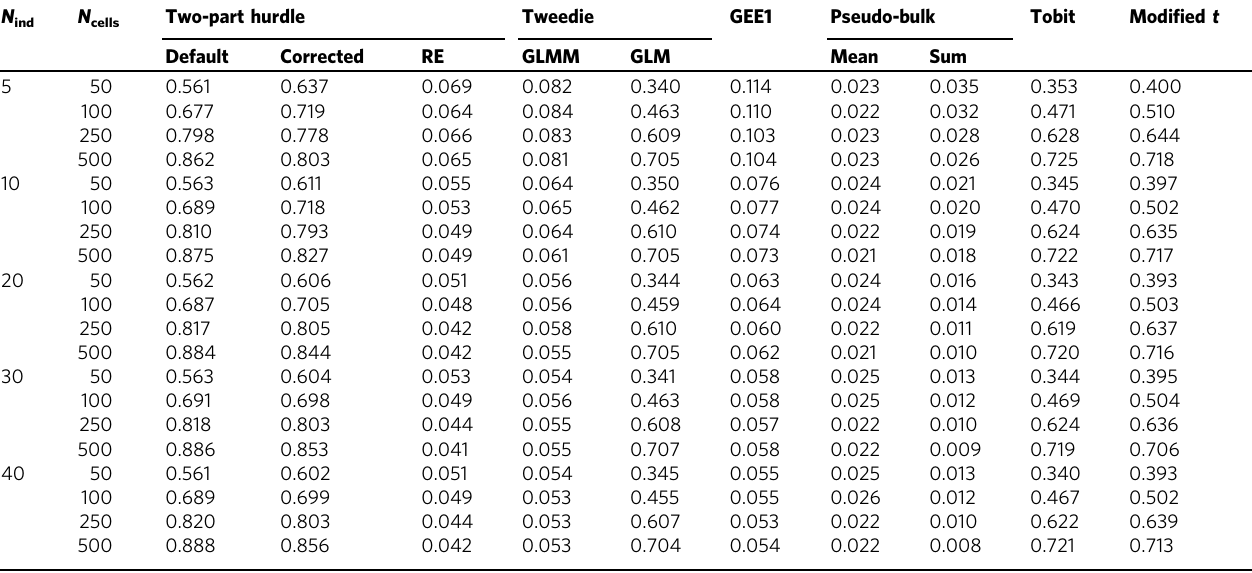
Table 1 Type I error rates of some currently applied tools in single-cell analyses. Type I error rates of ten different methods under twenty different conditions and a signi fi cance threshold of p < 0.05. In all, 250,000 iterations were computed to obtain an error rate for each method. The in fl ated type I error rates computed with mixed models at the lower number of individuals per group are a consequence of the two-part hurdle model simultaneously testing two hypotheses and an overabundance of subsampling with small sample sizes. Type I error rates are well-controlled for with mixed models and pseudo-bulk methods, while type I error rates increase with other methods as additional independent samples or more cells are added. Pseudo-bulk methods are overly conservative. Con fi dence intervals (95%) are included in the enlarged version of this table (Supplementary Table